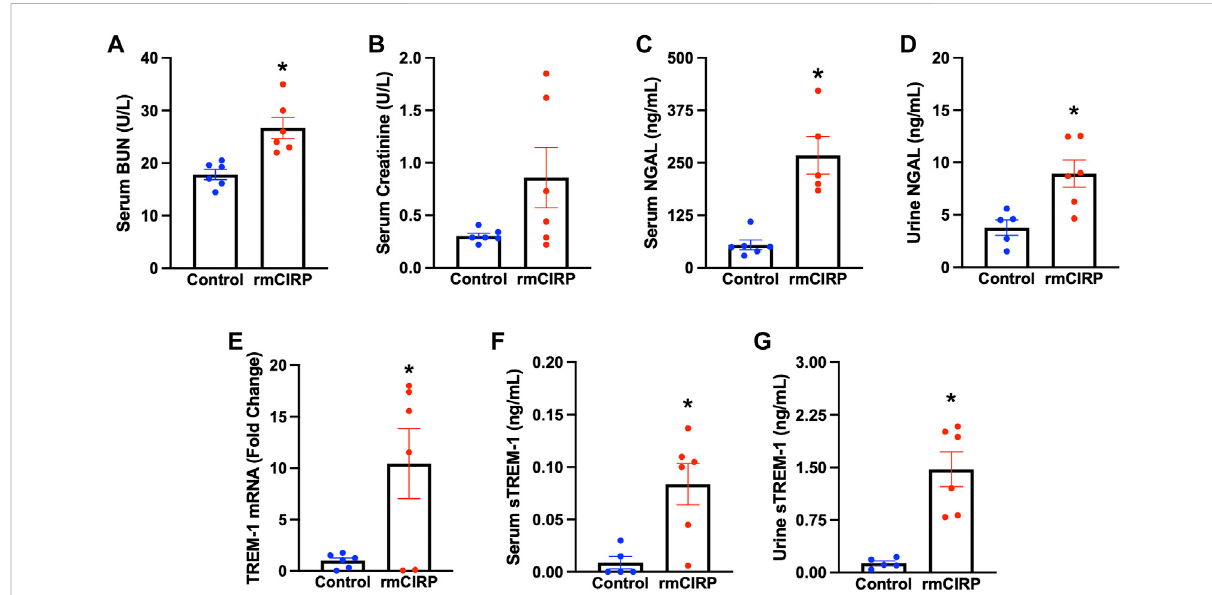
FIGURE 1 eCIRP induces AKI and TREM-1 activation. Adult C57BL/6 mice were randomly assigned to normal control or intravenous injection with recombinant murine (rm) CIRP. At 6 h after the injection, serum levels of (A) BUN and (B) creatinine ( p = 0.08) were determined using speci fi c colorimetric enzymatic assays, n = 6 mice per group. (C) Serum and (D) urine levels of NGAL were measured by ELISA, n = 5 – 6 mice per group. (E) RenalmRNAexpressionofTREM-1,andserum (F) and (G) urinelevelsofsTREM-1weremeasuredbyRT-PCRandELISA,respectively, n =6mice per group. All groups were compared using Student ’ s t-test. * p < 0.05 vs. control. Data are expressed as mean ±